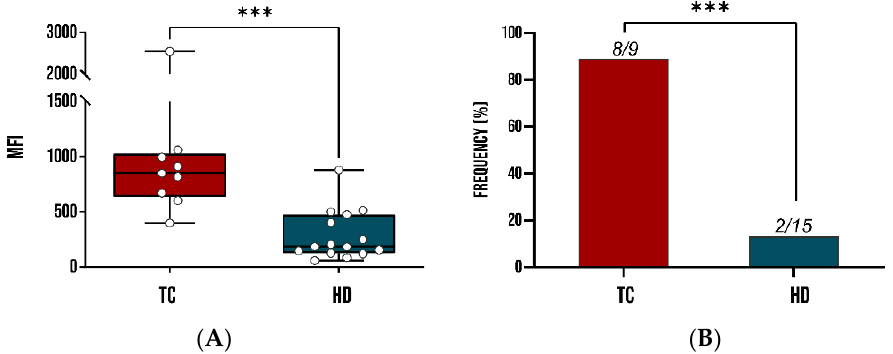
Figure 3. Immunoreactivity studies of recombinant Tc SMP in sera from patients infected by T. cruzi in comparison with healthy donors (HDs). A whisker plot comparing mean fluorescence intensity of mean fluorescence intensity (MFI) of Tc SMP tested against the sera of 9 T. cruzi -infected patients and 15 HDs. ( A ) Each dot represents the MFI of a single patient. ( B ) Recognition frequency of Tc SMP as determined by DELFIA assay. ***: statistical significance p < 0.0001 Student’s t -test and Fisher’s exact test, p < 0.0001 for MFIs and recognition frequencies. TC: T. cruzi patient sera; HD: healthy